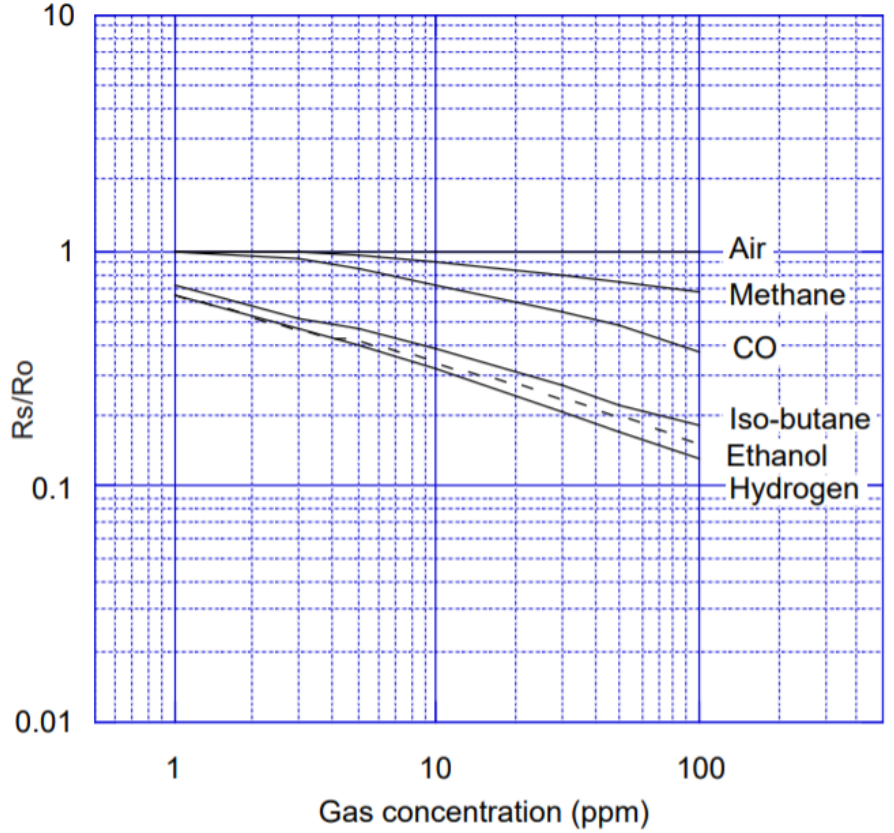
Figure 6. TGS2600 sensor characteristic